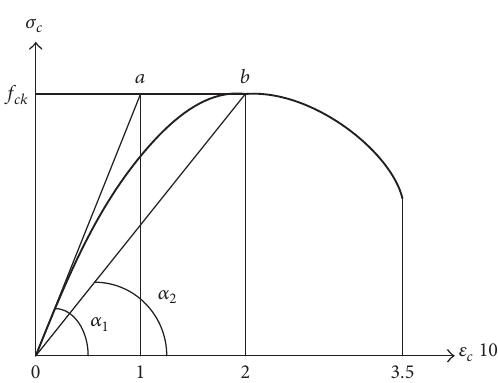
Figure6:Influenceofconcreteelementdeformationsonitsstiffness